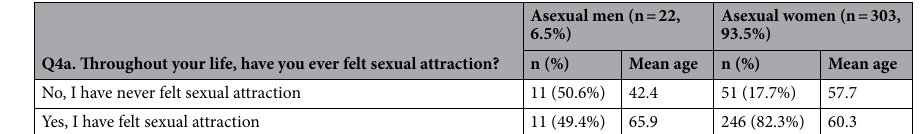
Q4a. Throughout your life, have you ever felt sexual